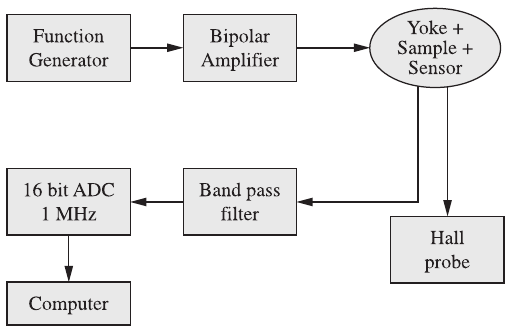
Figure 4. Upper part of figure shows Barkhausen noise as collected, and lower part shows FFTs calculated from each region of noise